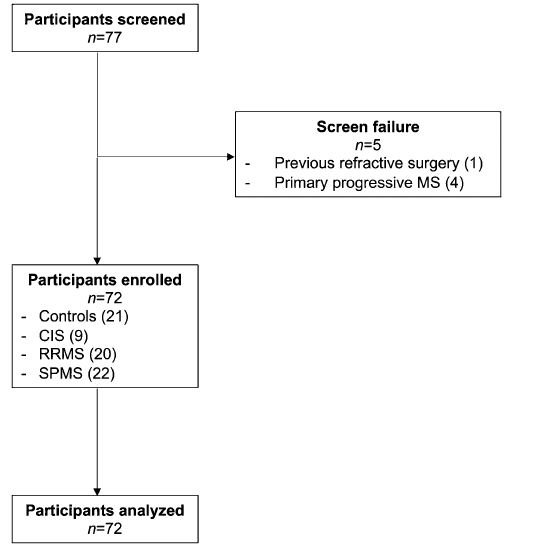
Figure 3. Flowchart of the study